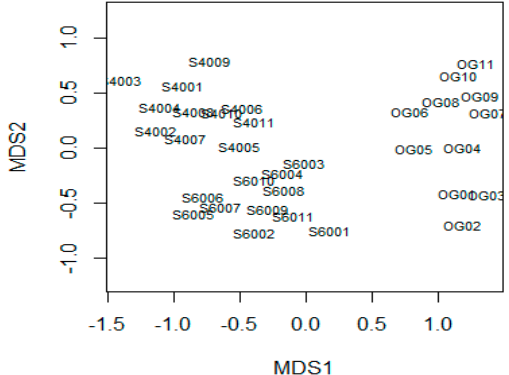
Figure 1. The multidimensional scaling (MDS) ordination plots of species abundance in tropical monsoon forests at different stages: the plots for 40-year forests were represented by the marks from S4001 to S4011; the plots for 60-year forests were represented by the marks from S6001 to S6011, and the plots for old-grown forests were represented by the marks from OG01 to OG11.